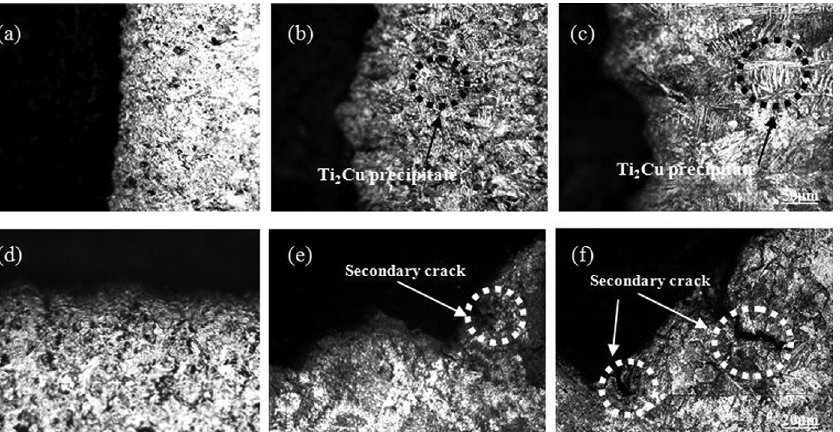
Figure 11: Metallographic photos of Ti-7Cu alloy with forging ratio of 60% at different temperature (a) and(d) 1000 ℃ ; (b) and (e) 1050 ℃ ; (c) and (f)1100 ℃